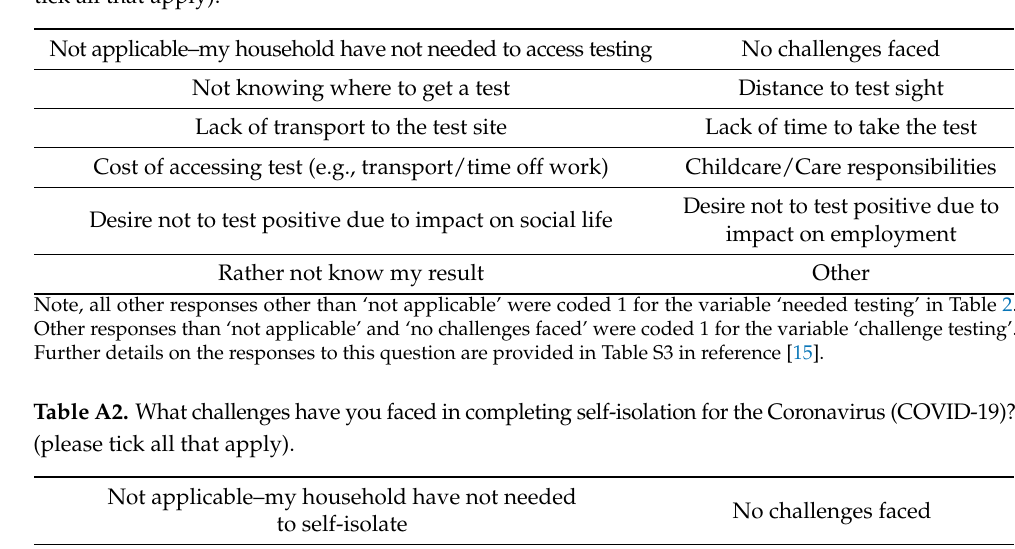
Table A1. What challenges have you faced in accessing Coronavirus (COVID-19) testing? (please tick all that apply).